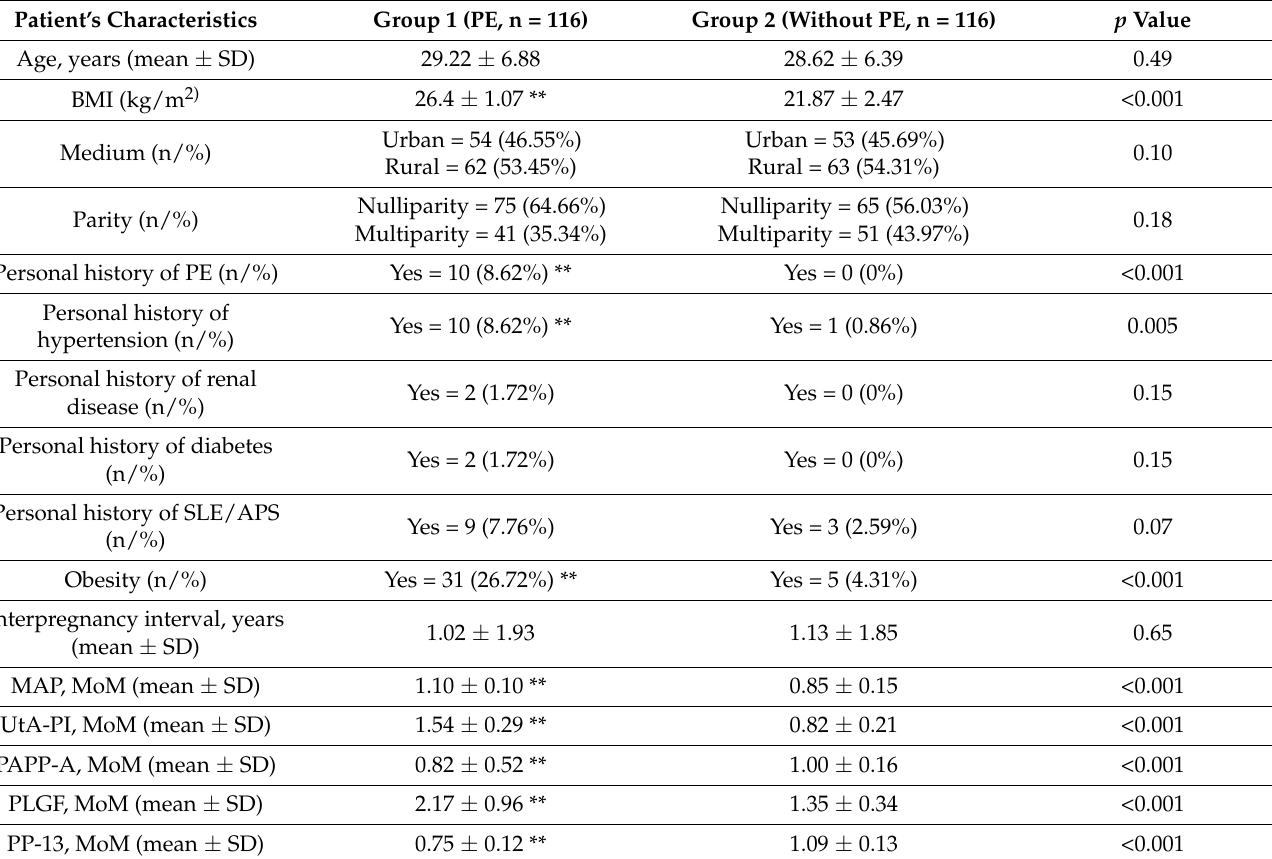
Table 1 legend: PE—preeclampsia; SD—standard deviation; APS—antiphospholipid syndrome; SLE—systemic lupus erythematosus; MoM—multiples of median; MAP—mean arterial pressure; UtA-PI—uterine artery